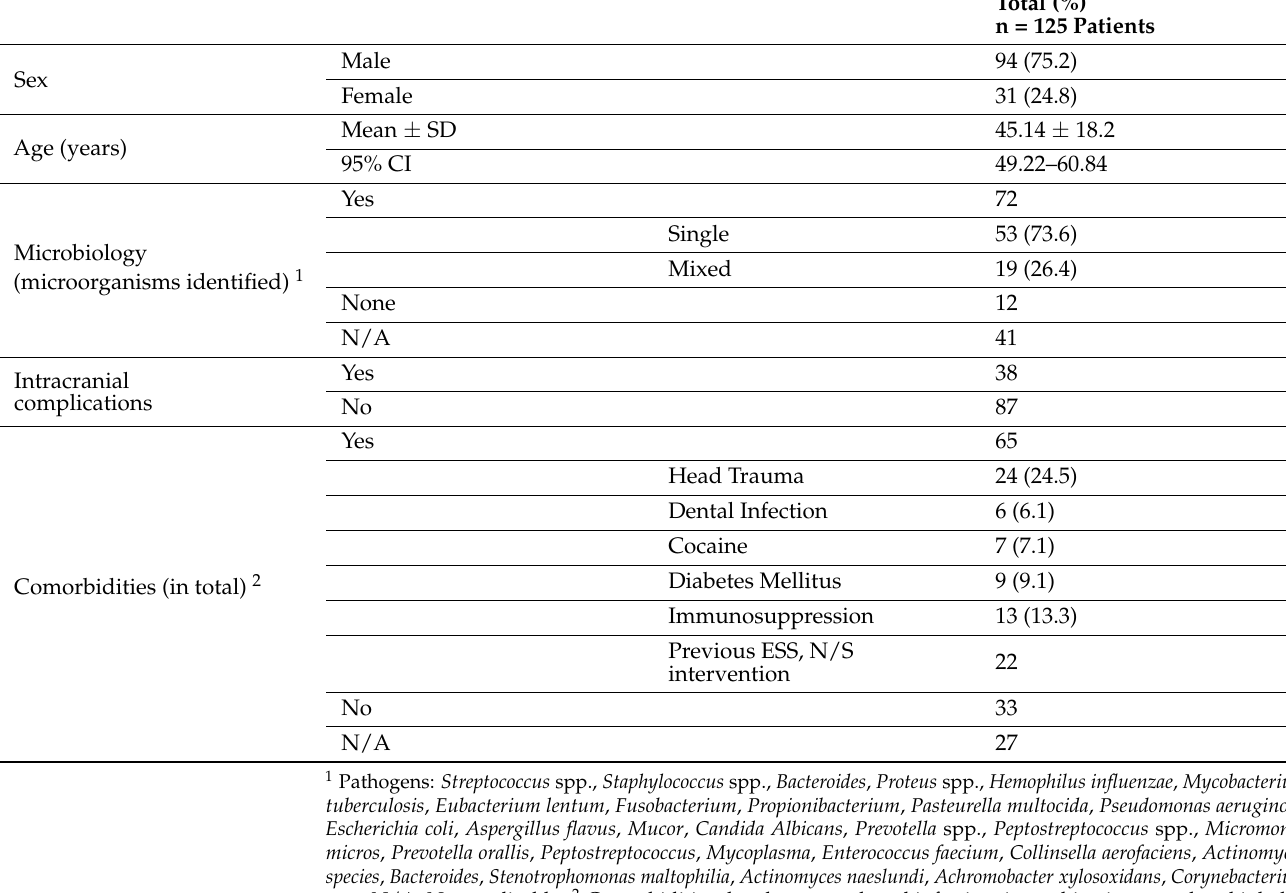
Table 1. Clinical characteristics of adult PPT patients from